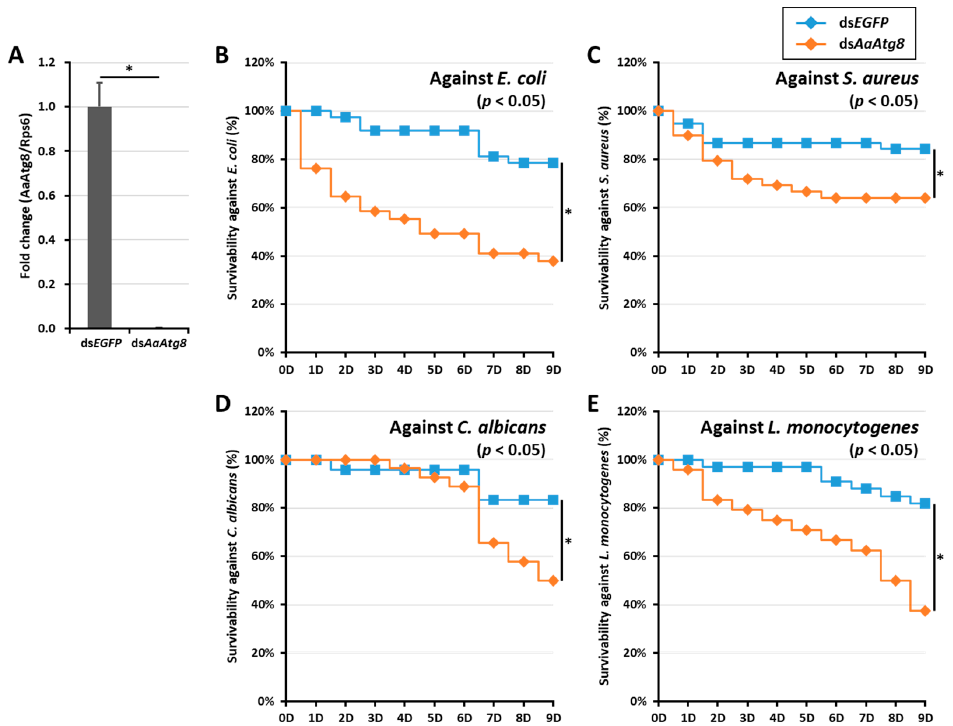
Figure 6. Effects of AaAtg8 mRNA silencing on mosquito survivability against microbial feeding. ( A ) RNAi efficiency of AaAtg8 mRNA in the ds AaAtg8 -injected adult mosquito group (n > 24) compared with the ds EGFP -treated group. Four different pathogens, E. coli ( B ), S. aureus ( C ), C. albicans ( D ), and L. monocytogenes ( E ), were fed in blood to the ds AaAtg8 -treated adult mosquito group and the survivability was investigated for 9 days. Data represent the average of three independent biological replications. The survivability curve is represented by a Kaplan–Meier plot and an asterisk (*) indicates a significant difference at 95% confidence levels.